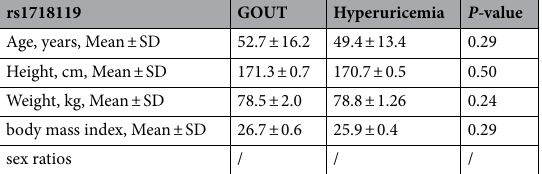
Table 2. Age, height, weight, body mass index, and sex ratios at presentation between the two groups.